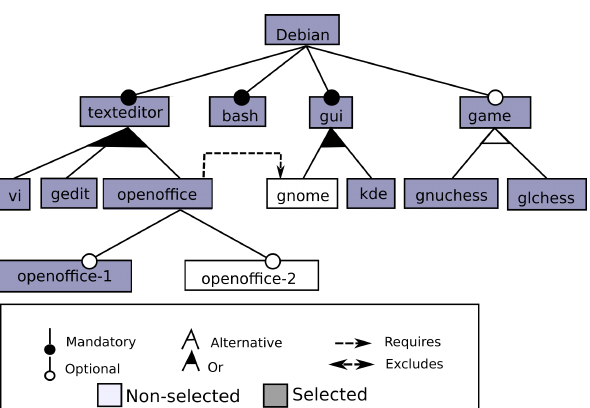
Figure 1. Feature model with a valid configuration example [1].